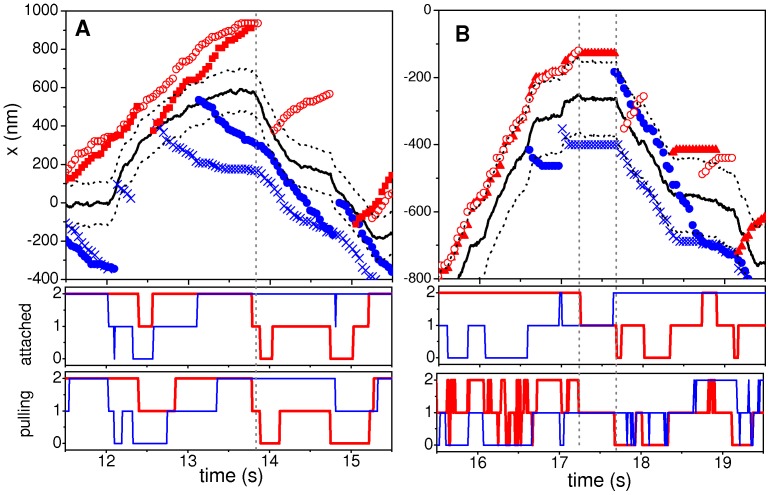
Trajectories of cargo and motors during reversions.(A) Details of the reversion shown in Figure 7A (RS, k = 0.02 pN/nm). (B) Ibid for the reversion shown in Figure 7C (system with k = 0.3 pN/nm). In both panels, the cargo trajectories are indicated by thick solid lines while different red and blue symbols are used for forward and backward motors, respectively. The limits for pulling (positions xc(t)±x0) are indicated by dotted lines. The bottom panels indicate the numbers of attached and pulling motors of both species as function of time during the reversion. The vertical dotted segments indicate relevant detachment events for the reversions.